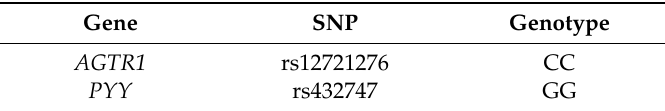
Table A4. List of SNPs discarded for analyses because all individuals of the sample had the same